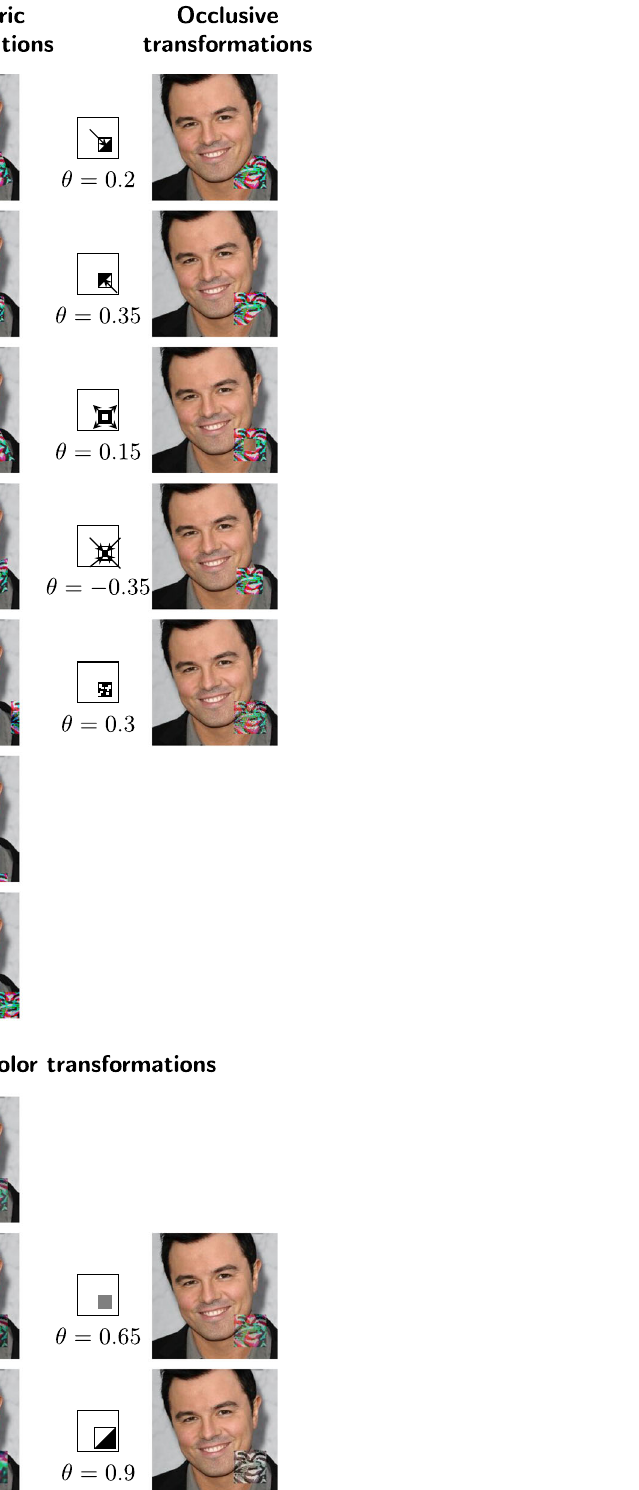
Fig. 12 Visualization of transformed triggers for which the empirical ASR is below 0.5 over the entire dataset. For each transformation, the closest parameter value with respect to the baseline is depicted and reported below the